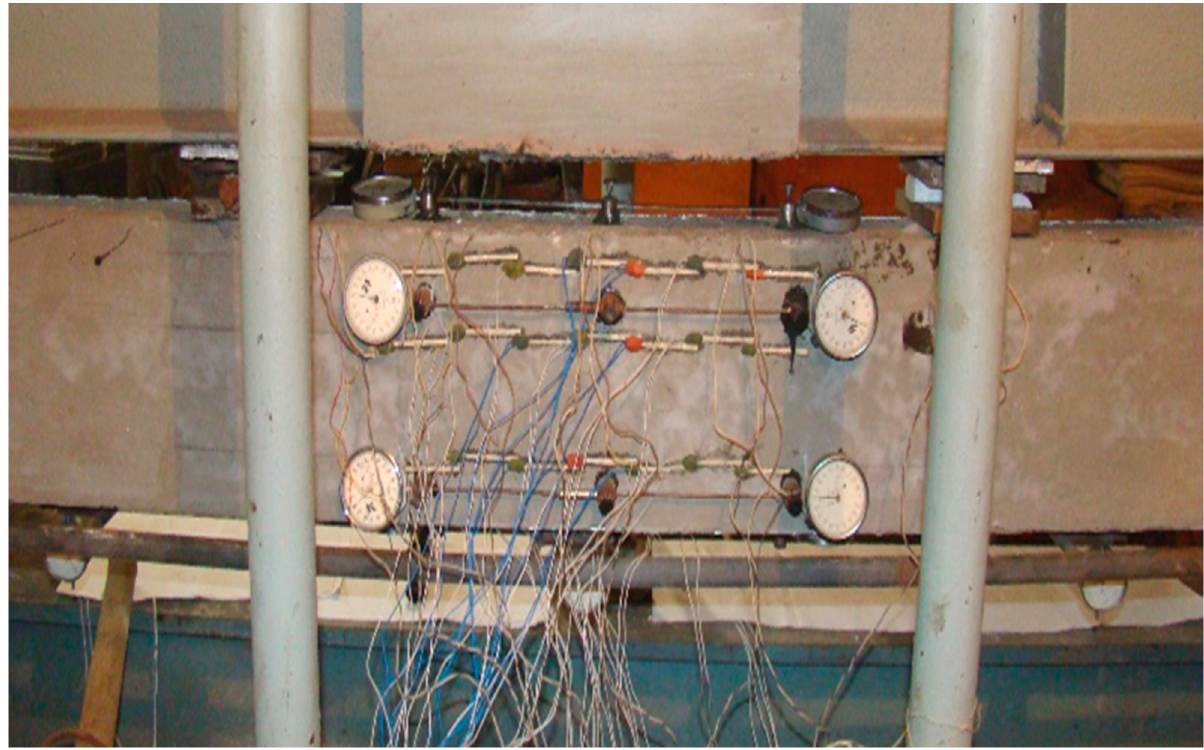
Figure 4. Placement of strain gauges and microindicators on the beam.